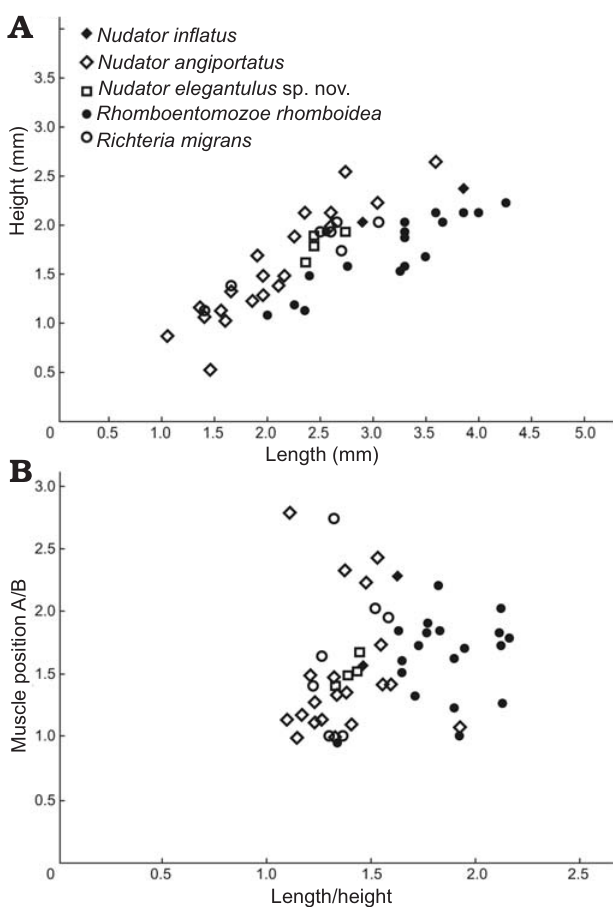
Fig. 4. Valve length/height plot ( A ) and position of the adductor muscle scar (A/B, where A and B are the distance between the muscle scar and the posterior end of the valve and the ventral margin, respectively) against length/height ( B ) of complete specimens of entomozoid species from